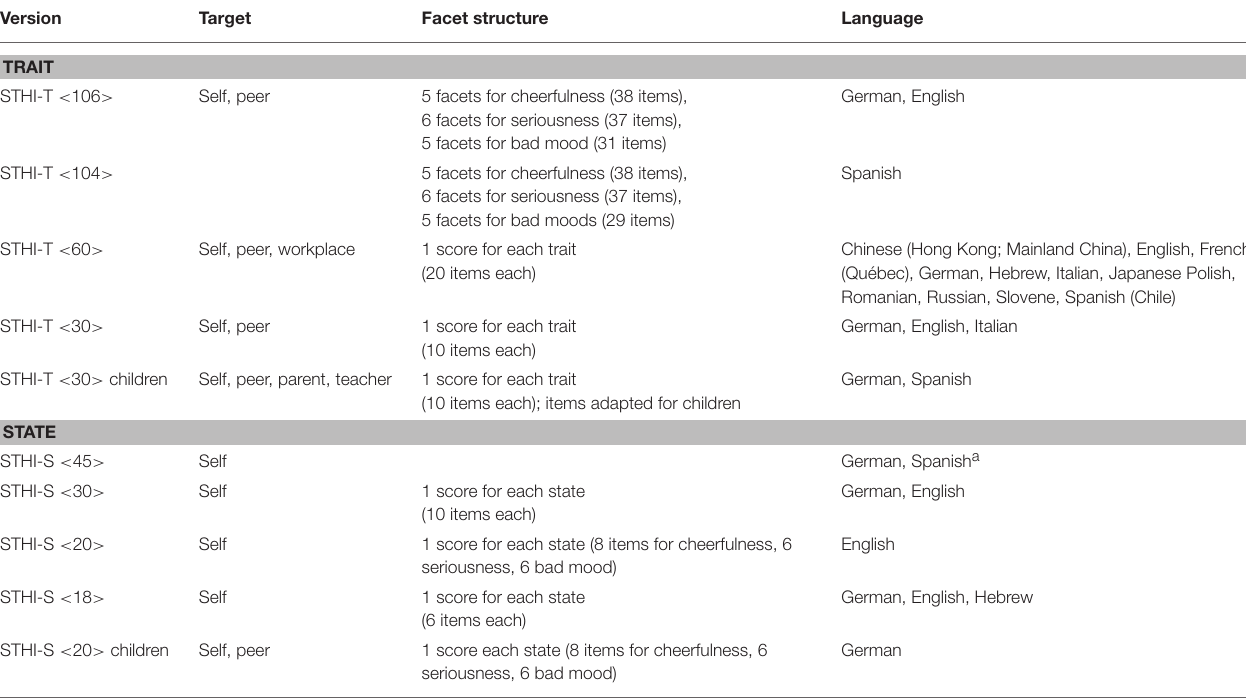
TABLE 1 | Overview of the different versions of the STCI-T and STCI-S (adapted from Ruch and Hofmann,